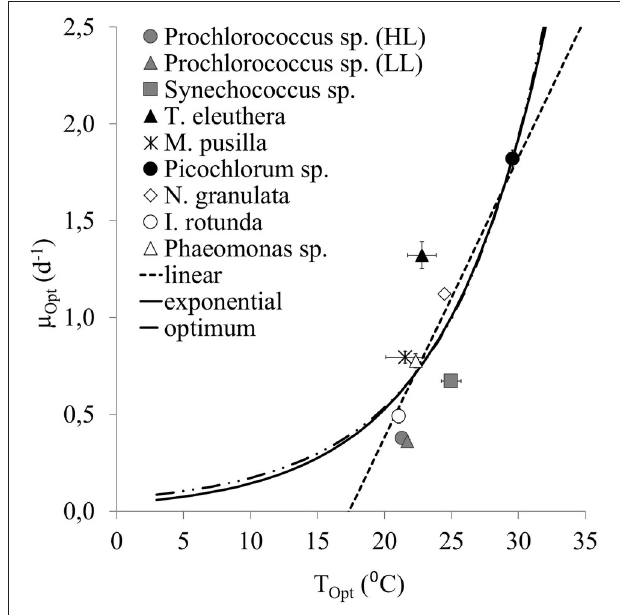
FIGURE 4 | A linear, exponential and optimum fit through optimum growth rates at optimum temperatures of the individual strains examined within this study. Error bars represent the standard